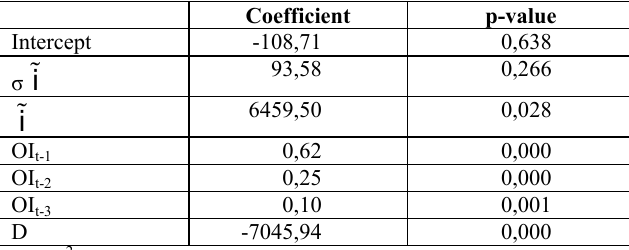
Table 10: Regression summary of volatility on